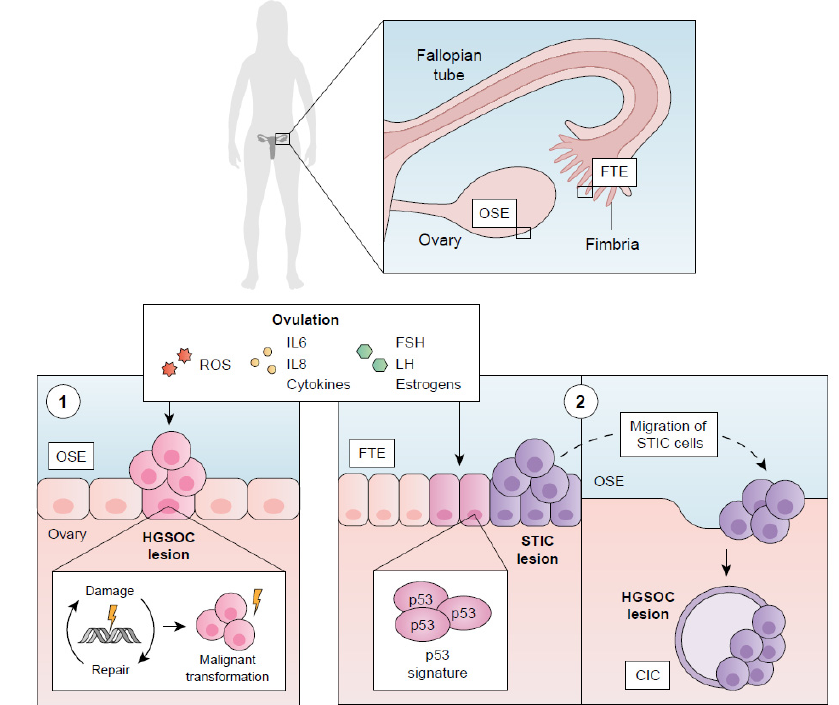
Figure 1. Two main theories of the cellular origin of high-grade serous ovarian carcinoma (HGSOC): ( 1 ) Reactive oxygen species (ROS), inflammatory molecules (IL-6, IL-8, and cytokines), and hormones (FSH, LH, and estrogens) released during ovulation induce constant tissue damage and repair cycles, leading to HGSOC in the ovarian epithelial surface (OSE), which might also be triggered by the formation of cortical inclusion cysts (CICs). ( 2 ) Alternatively, malignant transformation triggered by the pro-inflammatory and pro-oxidative environment generates serous tubular intra-epithelial carcinoma (STIC) lesions in the fallopian tube epithelium (FTE), which give rise to HGSOC after migrating and invaginating in the OSE as CICs.